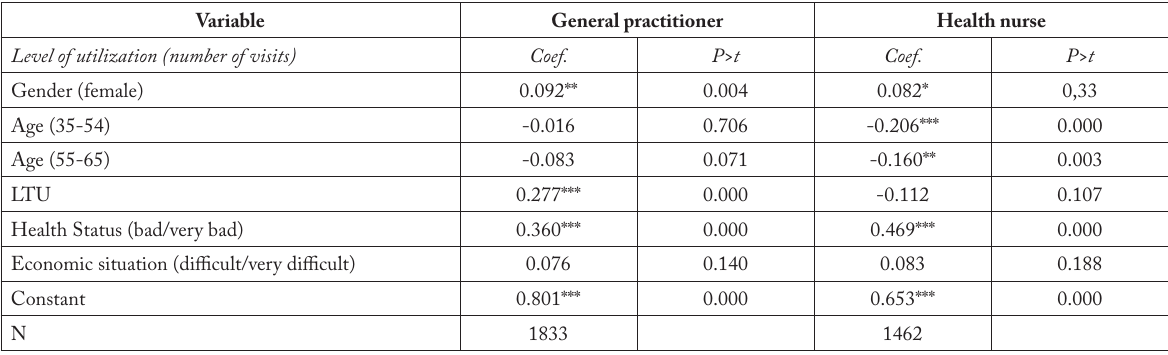
Table 4. Estimation results of the level models (number of visits)